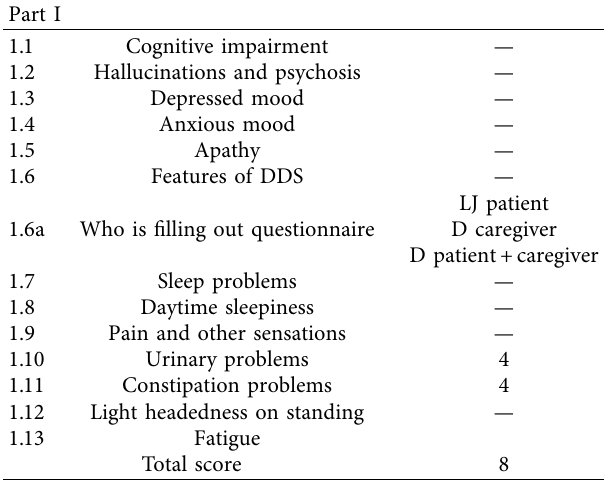
Table 3: Illustration of cutoff values for MDS-UPDRS Part I (scale from